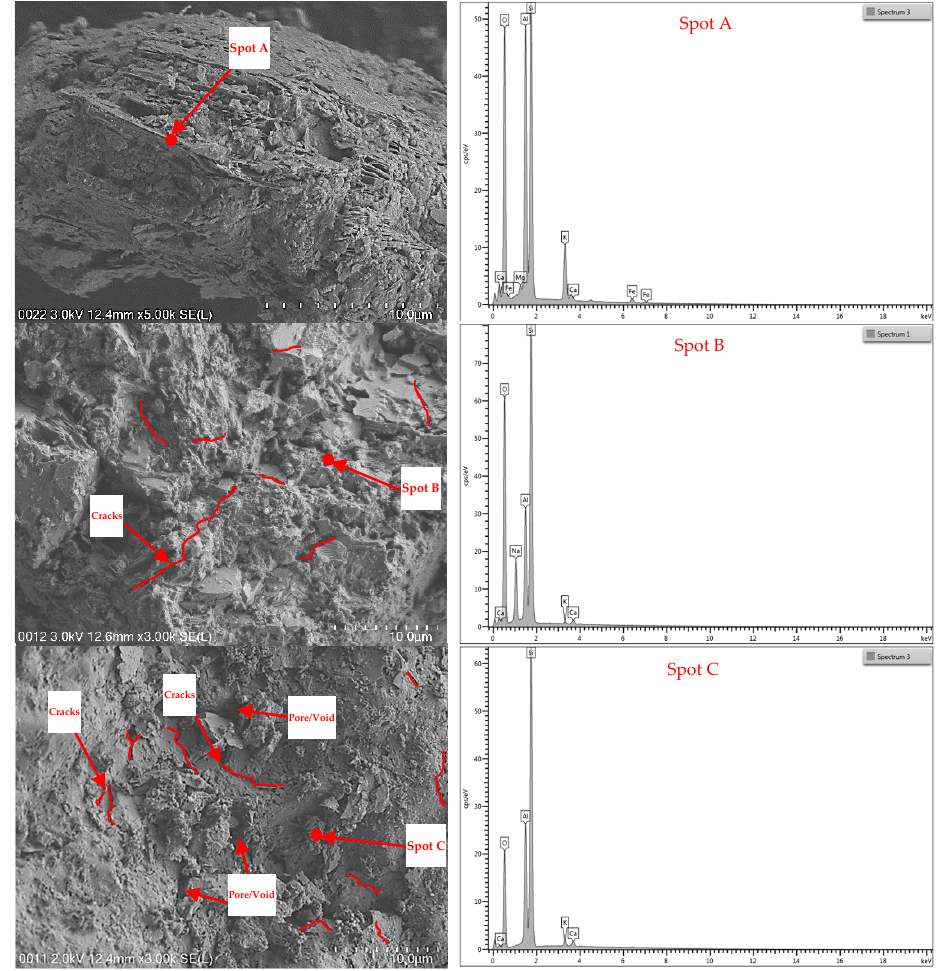
Figure 13. FESEM and EDX images of unheated and heated sand aggregates: Unheated sand at ambient temperature ( top row ); Heated sand at 600 ◦ C ( middle row ); and, Heated sand at 1000 ◦ C ( bottom row